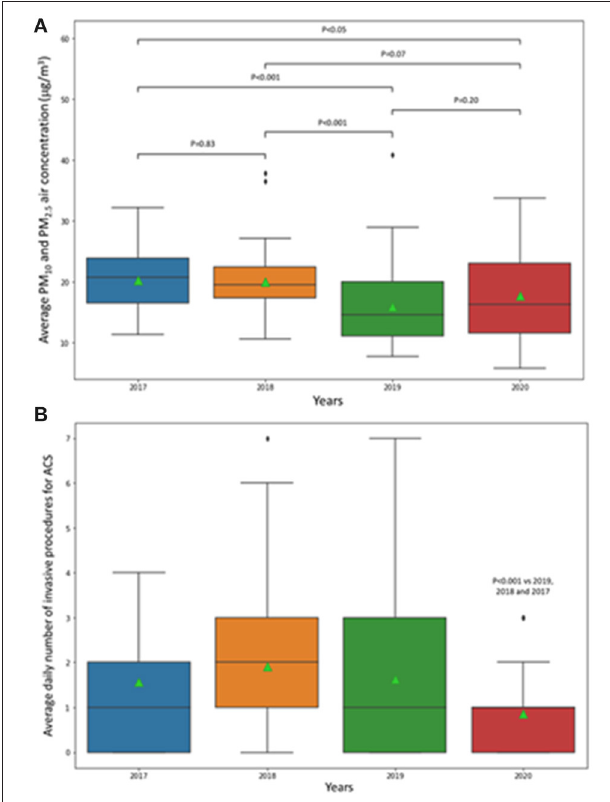
FIGURE 2 | Box and whiskers plot representing (A) the distribution of particulate matter (PM) 10 and PM 2.5 air concentration and (B) the distribution of the number of invasive procedures for acute coronary syndromes (ACS) recorded between March 9 and May 3 of 2020, 2019, 2018, and 2017. The ends of the box are the upper and lower quartiles; the horizontal line inside the box represents the median, and the green triangle denotes the mean. The end of the whiskers represents the upper and lower extremes; data beyond those values are